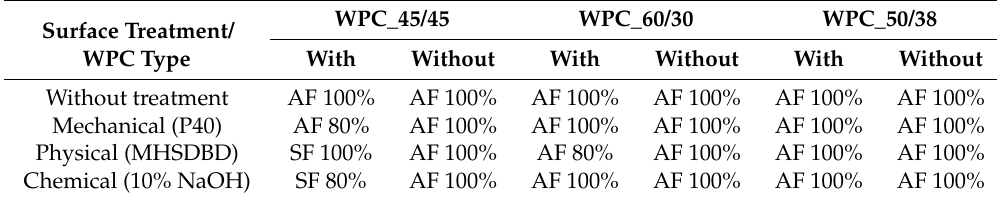
Table 3. Predominant failure mode of samples WITH and WITHOUT primer after shear test 1